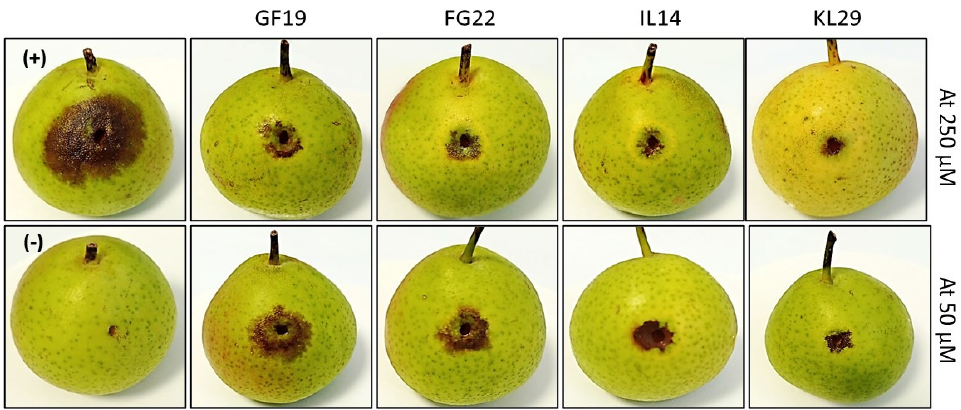
Figure 9. Antagonistic effect of selected antimicrobial peptides against Erwinia amylovora infection on detached immature pear fruits. ( − ) pear injected with sterile water and used as a negative control reaction; (+) pear fruit inoculated with Erwinia amylovora and used as a positive control reaction.